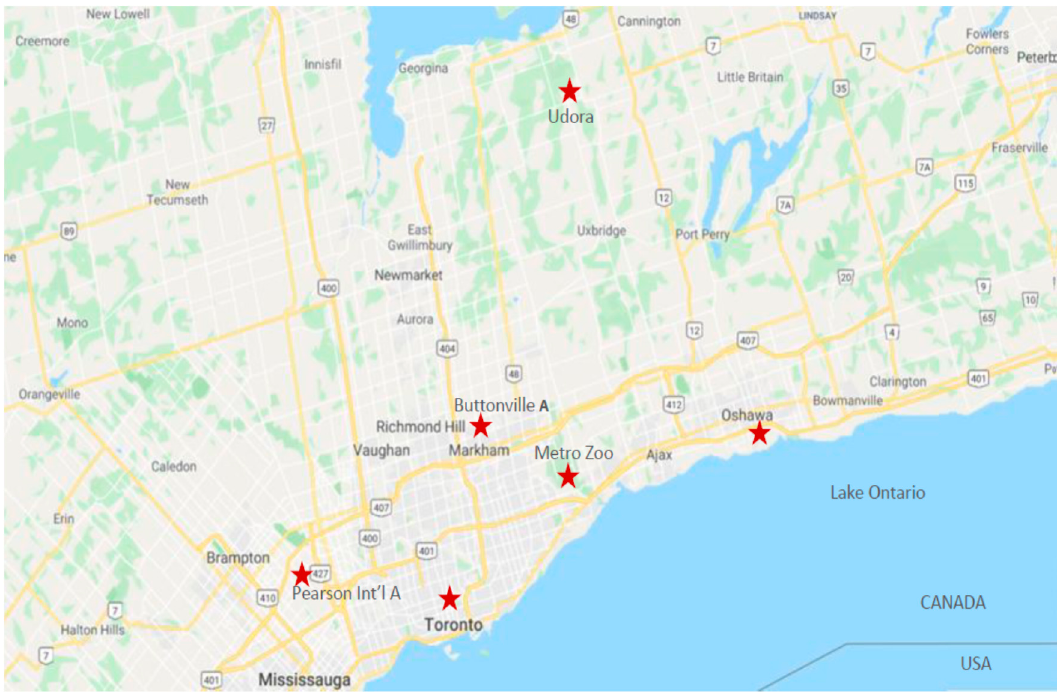
Figure 1. A map of the Greater Toronto Area in southern Ontario (Canada), including the Toronto (Metro) Zoo, as well as five surrounding weather stations.